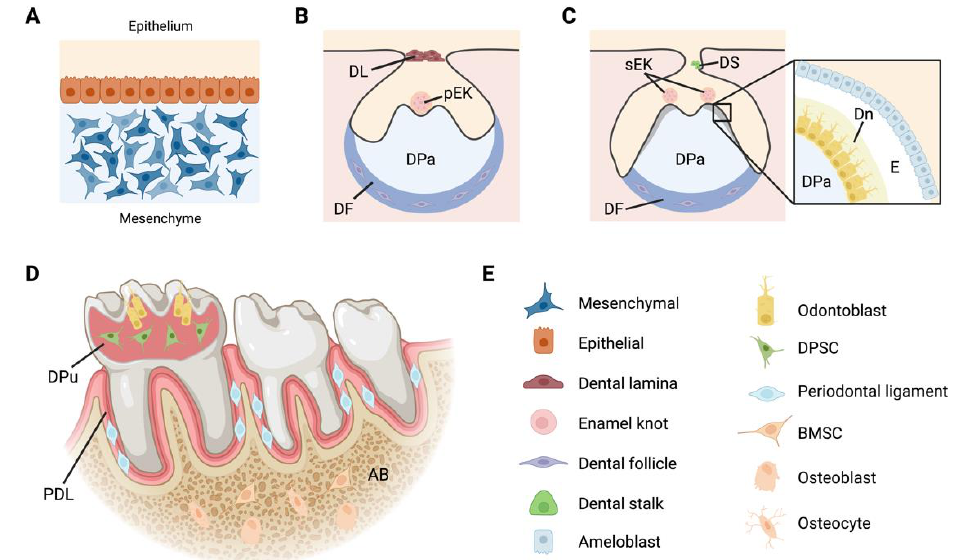
Figure 2. Dental cells known to contain primary cilia. Primary cilia are reported in cells that partic- ipate in tooth development ( A – C ) and make up the structures associated with fully formed teeth ( D ). ( A ) Cilia are detected as early as the initiation stage. ( B ) Cap stage: dental lamina (DL), primary enamel knot (pEK), dental papilla (DPa), dental follicle (DF). ( C ) Bell stage with magnified region where dentin (Dn) and enamel ( E ) are initially deposited: dental stalk (DS) and secondary enamel knot (sEK). ( D ) Fully developed and erupted molars anchored to alveolar bone (AB): dental pulp (DPu) and periodontal ligament (PDL). ( E ) Legend for the cells depicted in A–D: dental pulp stem cell (DPSC) and bone marrow stromal cell (BMSC). This figure was created with BioRender.com (accessed on 16 November 2022) .